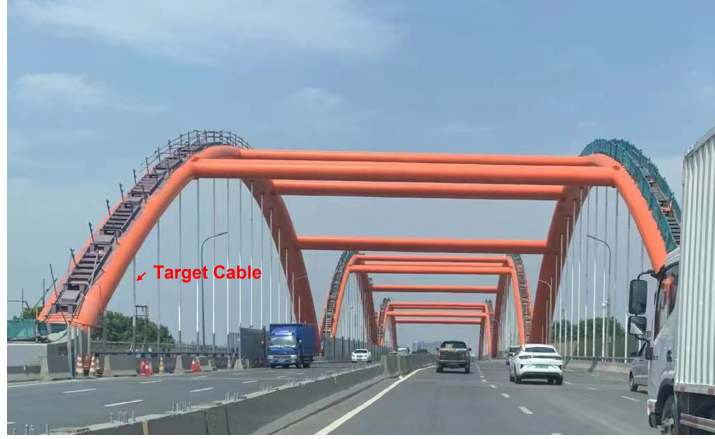
Figure 5. Experiment